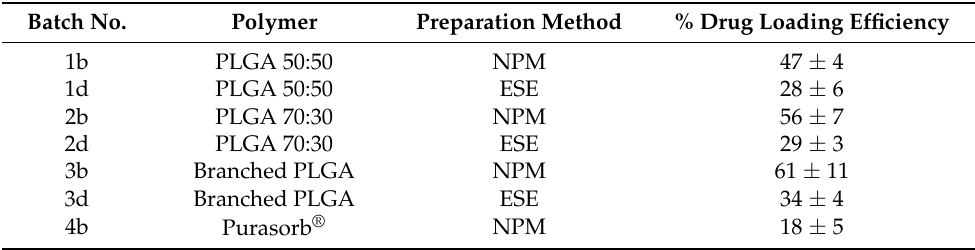
Table 2. Loading efficiency of Rhodamine B into PLGA nanospheres prepared using nanoprecipita- tion method (NPM) or emulsification solvent evaporation method (ESE). Batch No. Polymer Preparation Method % Drug Loading